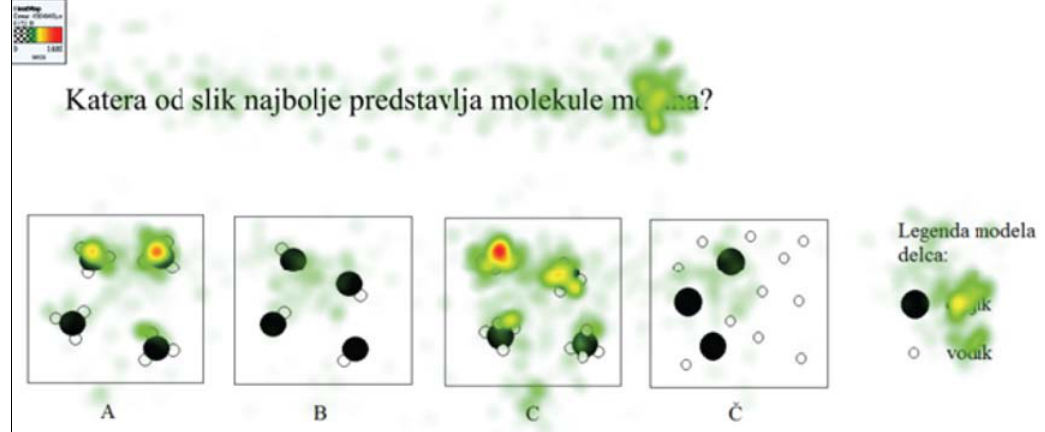
Figure 4. A heat map for Task 8 shows the relative density of fixations using a color gradient.